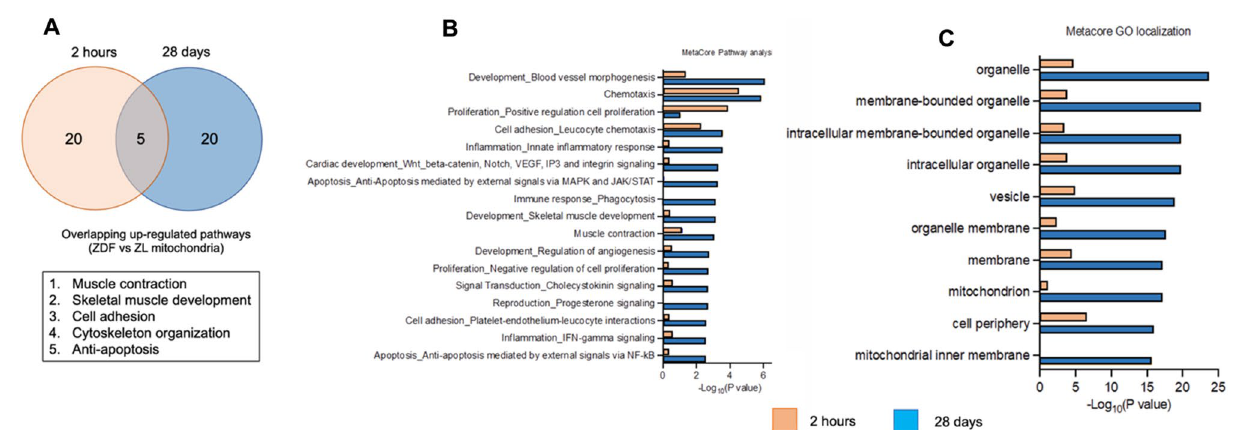
Figure 8. Top 25 upregulated pathways implicated in the transcriptomic differences between hearts receiving diabetic and non-diabetic mitochondrial transplantation. ( A ) Venn diagram of overlapping top 25 MetaCore process networks shows commonality in muscle contraction and development of pathways enriched for hearts receiving diabetic ZDF- and non-diabetic ZL-mitochondrial transplantation compared to Vehicle. ( B ) Gene set enrichment analysis using MetaCore process networks of ZL vs ZDF mitochondria groups combined for 2 h and 28 days. ( C ) Gene set enrichment analysis using MetaCore localization analysis of ZL vs ZDF mitochondria groups combined for 2 h and 28